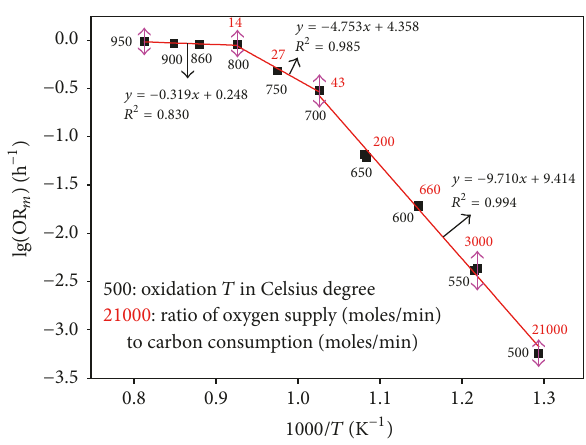
Figure 3: Arrhenius plot of MG oxidized in air at 500–950 ∘ C.